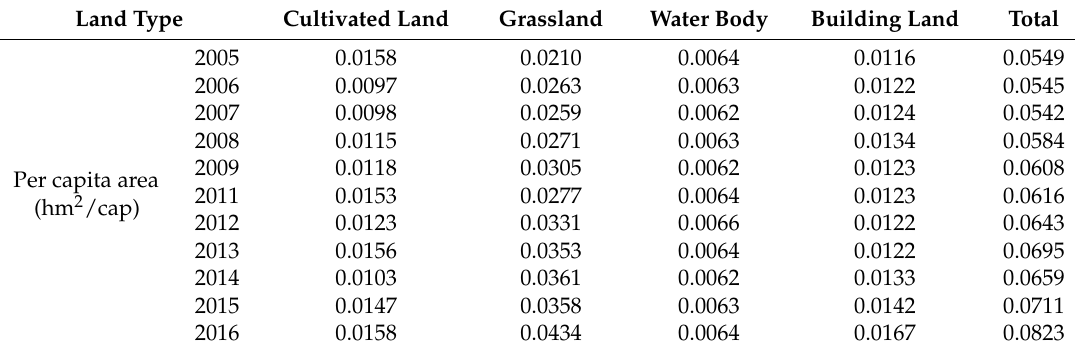
Table 11. Computational results of the per capita area of the study